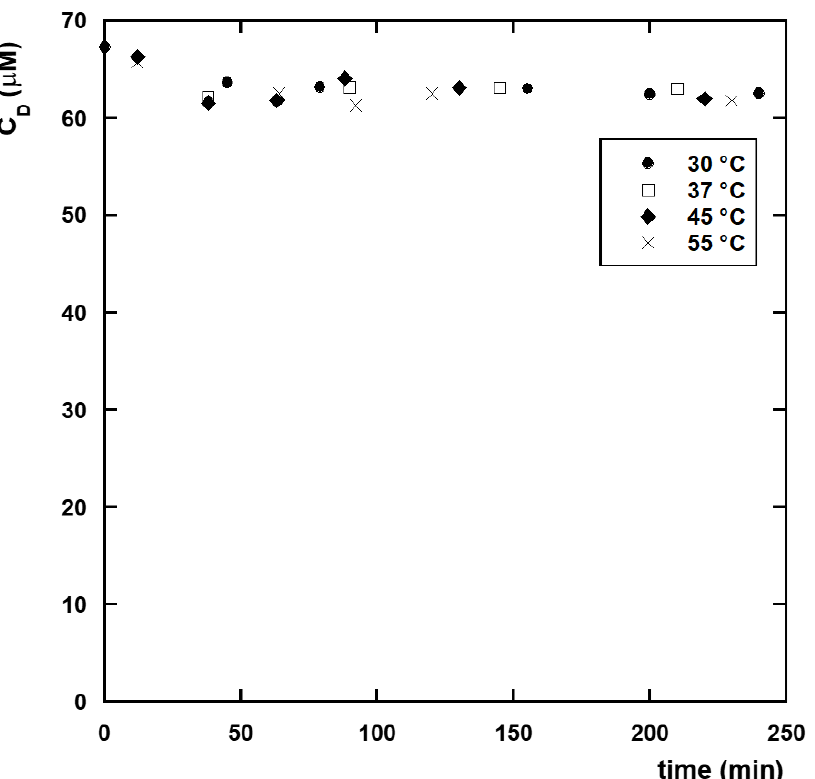
Figure 5. Diuron degradation kinetics profiles in the presence of MnO 2 (2.4 g L − 1 ) at different temperatures; initial pH = 4.3.